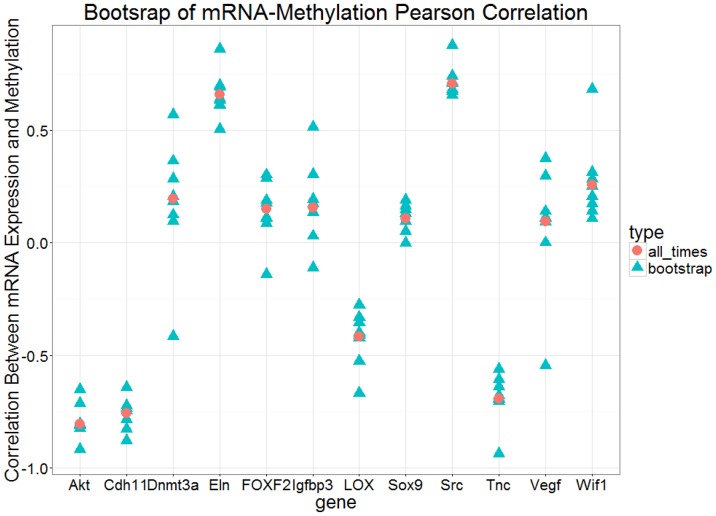
Bootstrap analysis of Pearson correlation r between expression and methylation datasets over eight time points for each gene.The red circles are the Pearson correlation over all eight points and the blue triangles are the Pearson correlation for all subsets of 7 points.